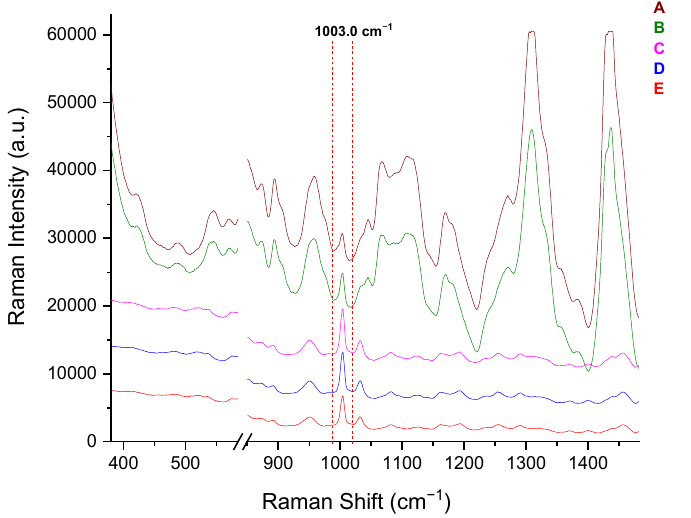
Figure 11. Raman spectra of the liquid formulation (40.00 mg PIP/mL and 5.00 mg TAZ/mL) placed in the drip chamber, each one corresponding to the radiation focus positions illustrated in Figure 10.